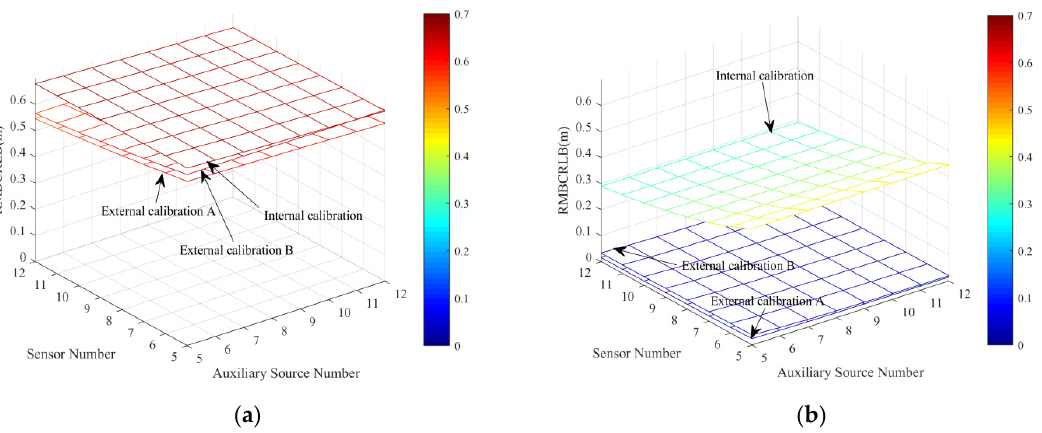
Figure 5. The RMBCRLBs for configuration calibration versus the number of auxiliary sources and sensors with σ 2 = 0.5 m 2 under different transmitting power parameters. ( a ) 10log( α 2 ) = 30 dBm 2 . ( b ) 10log( α 2 ) = − 10 dBm 2 .